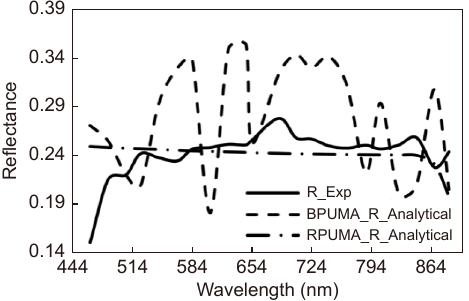
Fig. 11 | PUMA model evaluation with experimental